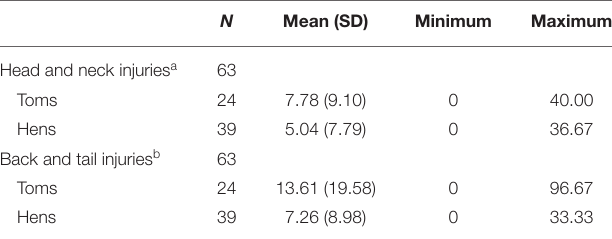
( Figure 1 , adapted from Knierim et al., 24) by each farmer on a TABLE 1 | Prevalence of pecking injuries from 63 commercial turkey flocks used in this